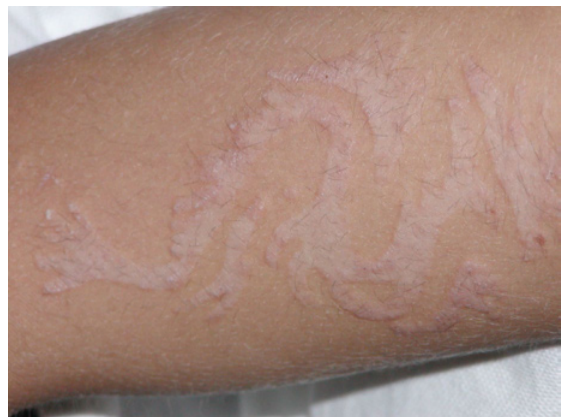
Figure 2. Eczematous dolphin-shaped reaction at the site of a henna tattoo on the right